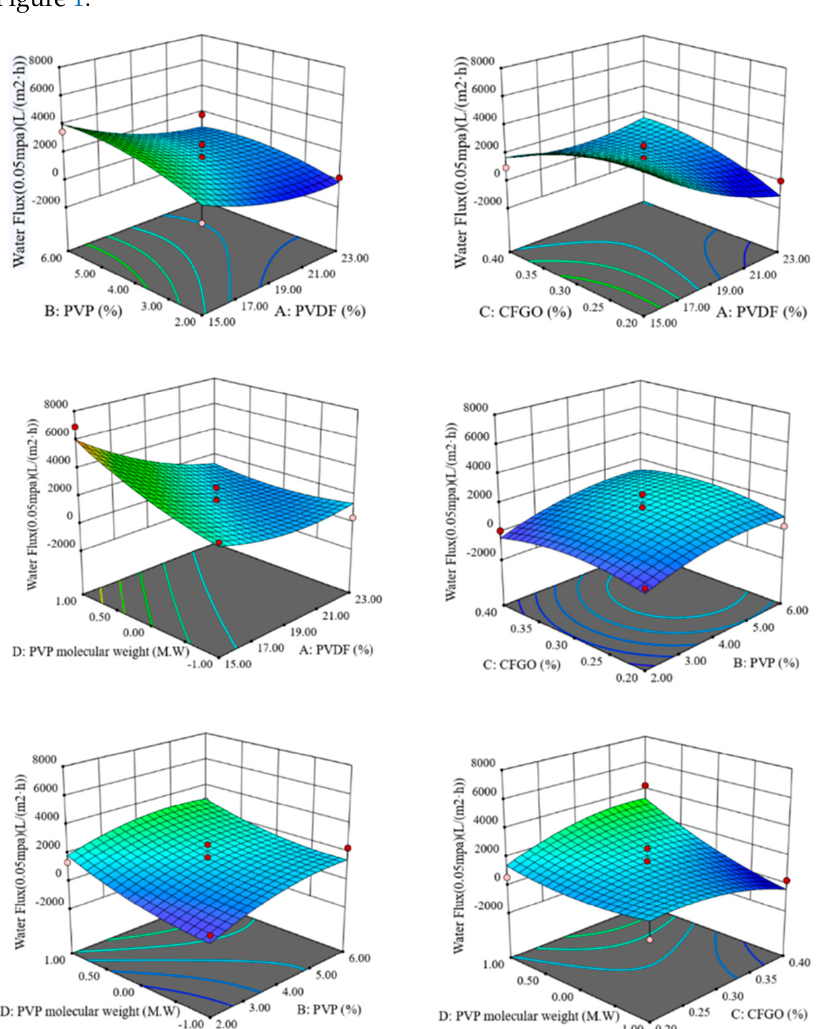
Figure 1. Response surface and contour of the interaction of various factors on pure water